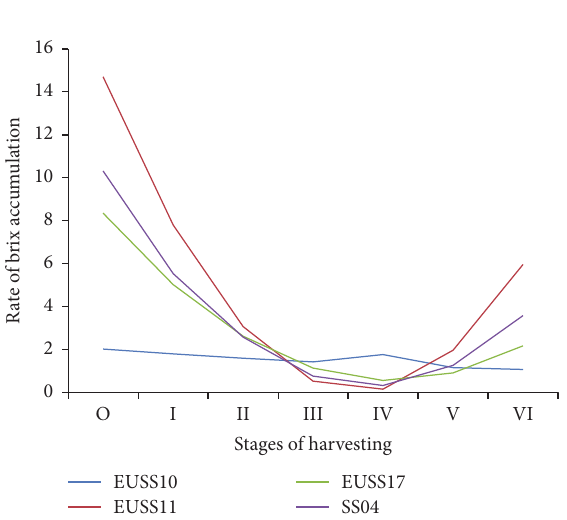
Figure 5: Rate of accumulation of brix against the stages of harvesting among the four genotypes, a polynomial of degree